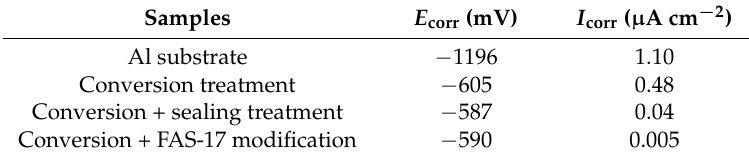
Figure 6. The polarization curves of 5052 aluminum alloy samples after different treatments. Table 1. Fitting results of the polarization curves for 5052 aluminum alloy after different treatments.